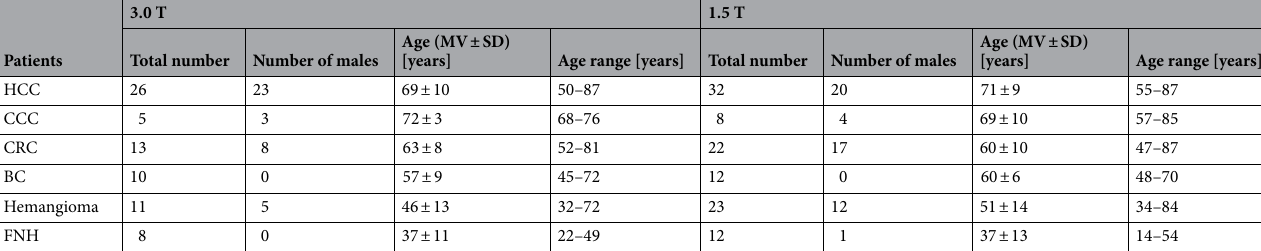
Table 1. Group composition and demographic data of included subjects at 3.0 and 1.5 T. MV—mean value, SD—standard deviation, HCC—hepatocellular carcinoma, CCC—cholangiocellular carcinoma,